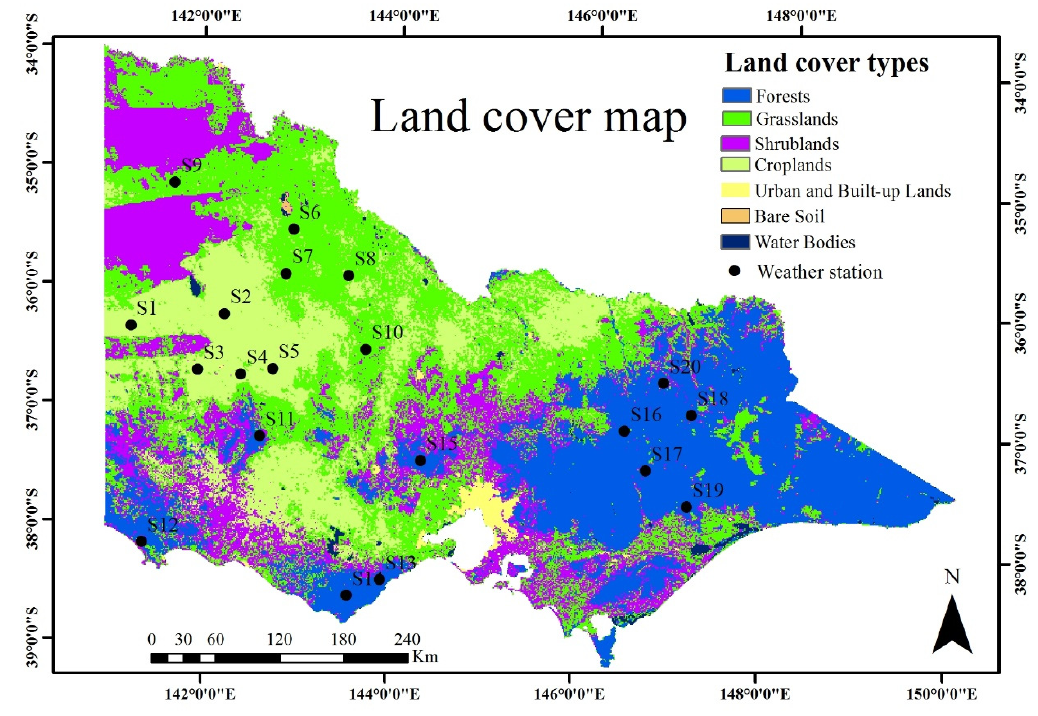
Figure 2. Land cover map of the study area.